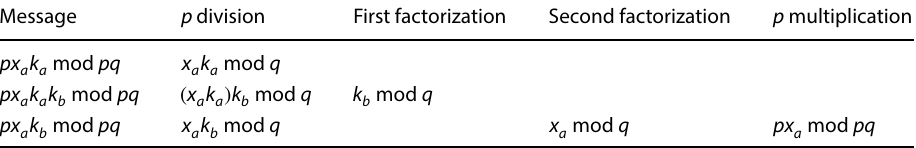
Table 3 The attacker applies Message p division First factorization Second p division to compute the multiplicative inverses of the public numbers to derive the secret value px a mod pq